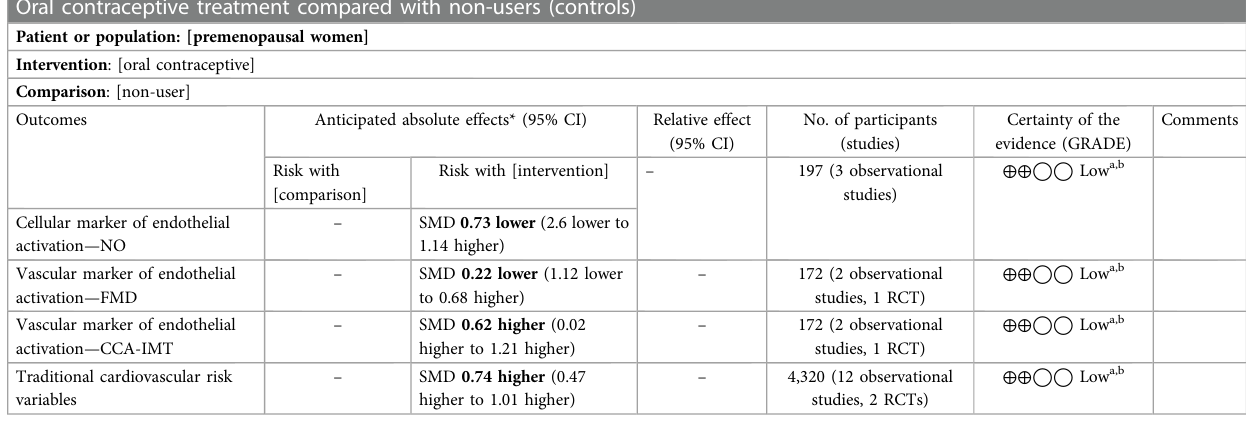
TABLE 4 Summary of fi ndings: use of oral contraceptives in premenopausal women compared with non-users. Oral contraceptive treatment compared with non-users